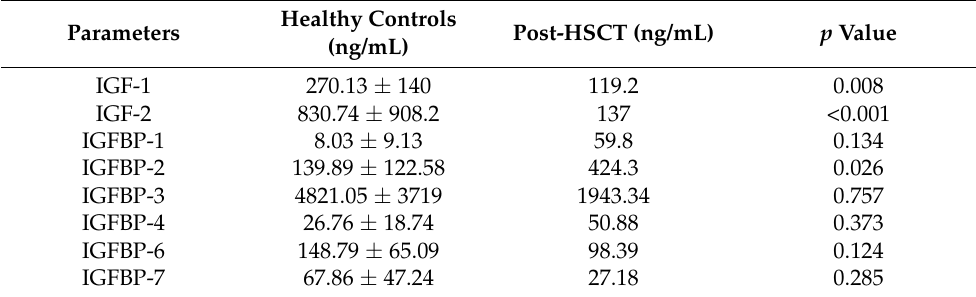
Table 6. Concentrations of IGFs and IGFBPs in healthy controls and post-HSCT